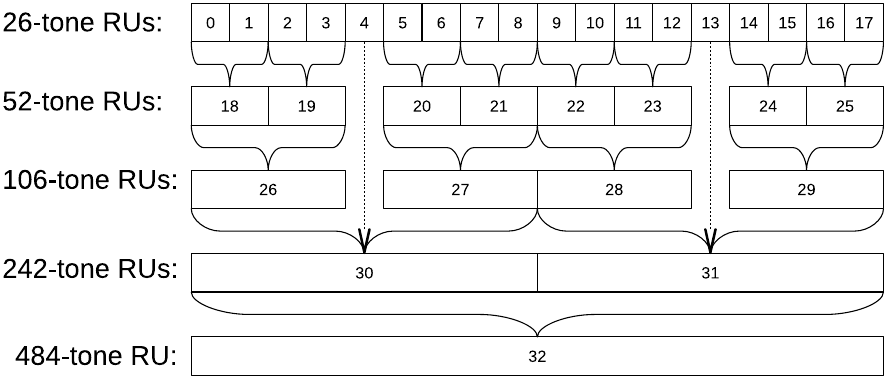
Figure 1. RU structure in 40 MHz